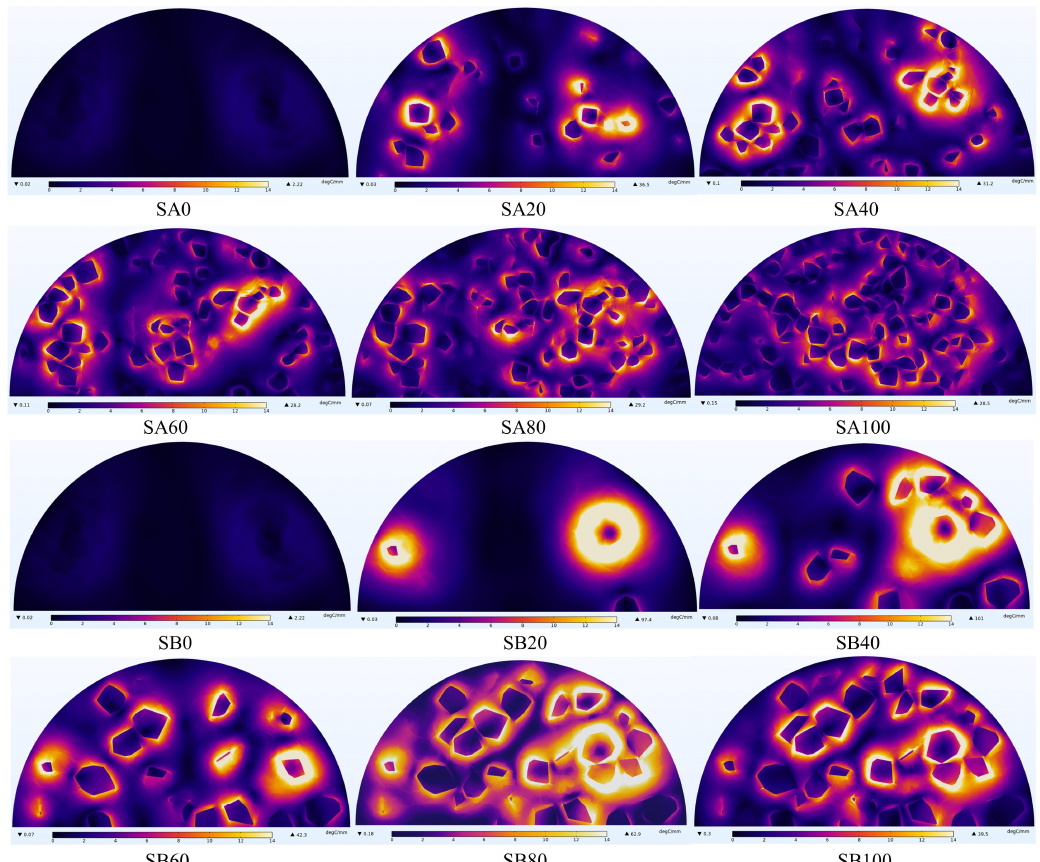
Figure 14. The temperature gradient distribution of steel slag asphalt mixtures.